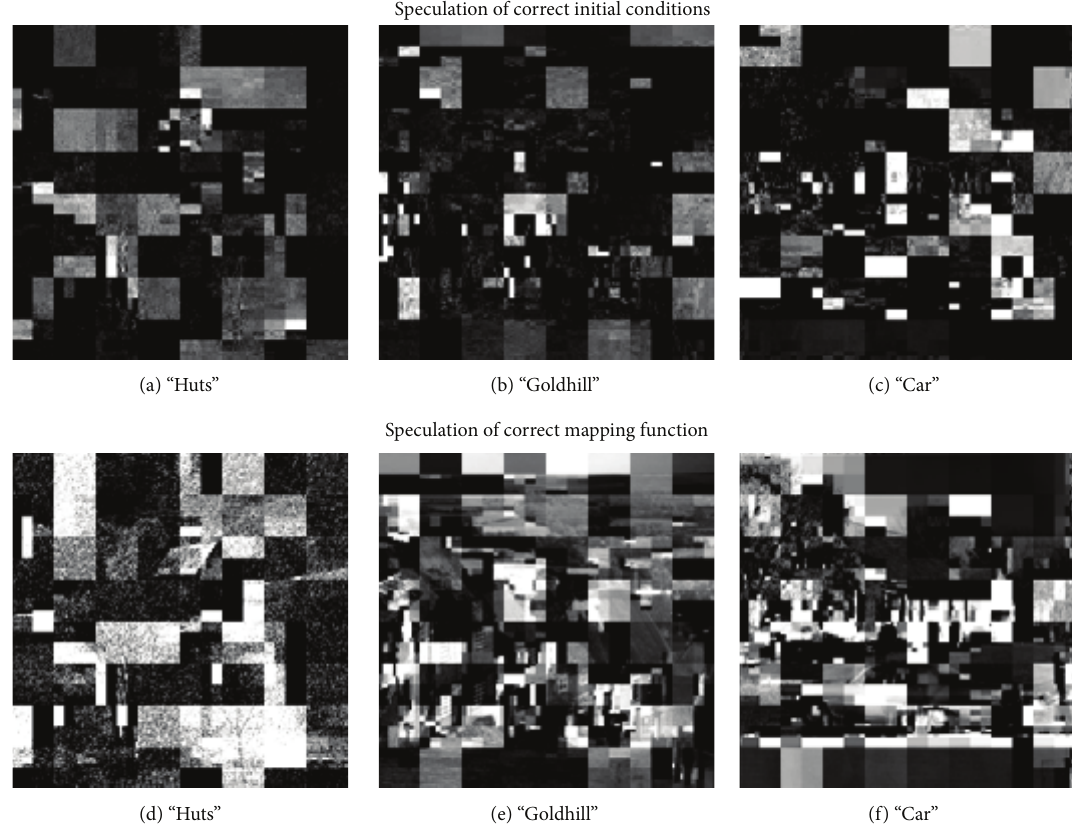
Figure 5: Brute-force attack